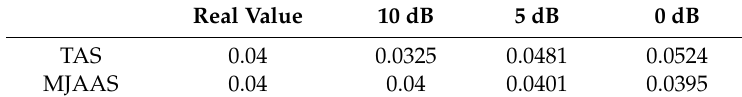
Table 4. The estimated results of ω e corresponding to NCM (rad/s).